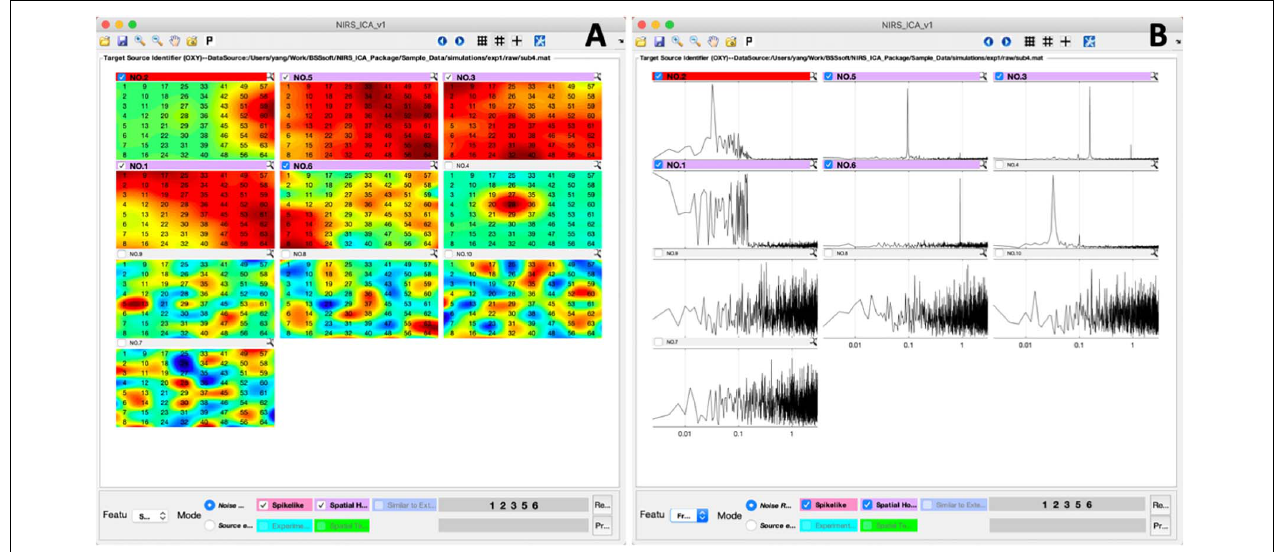
FIGURE 4 | The interfaces of sources selection according to their spatial maps (A) and frequency spectrums of the time course (B)